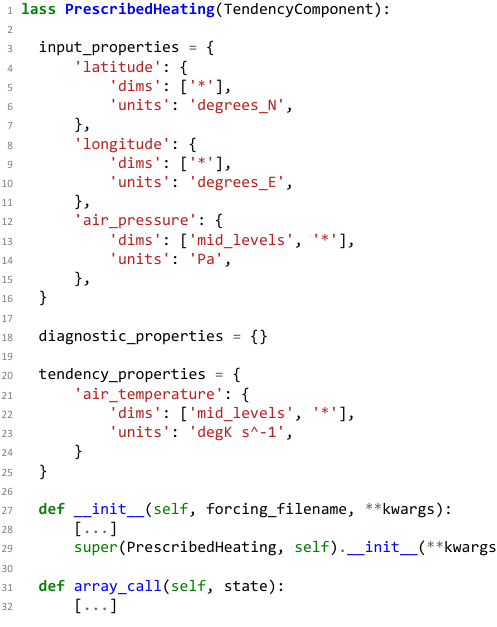
Figure 4. The general code layout for a sympl